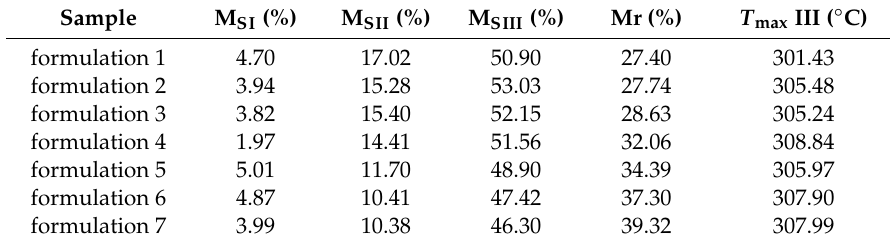
Figure 3. DTG curves ( a ) and TG curves ( b ) of investigated adhesives. Table 2. Thermal degradation data of the investigated adhesives.